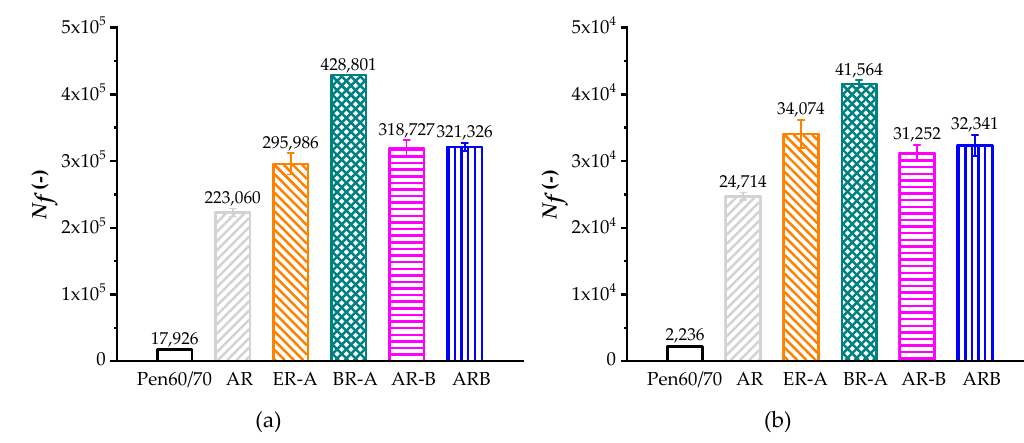
Figure 5. LAS test results: ( a ) applied strain of 2.5% and ( b ) applied strain of 5.0%.